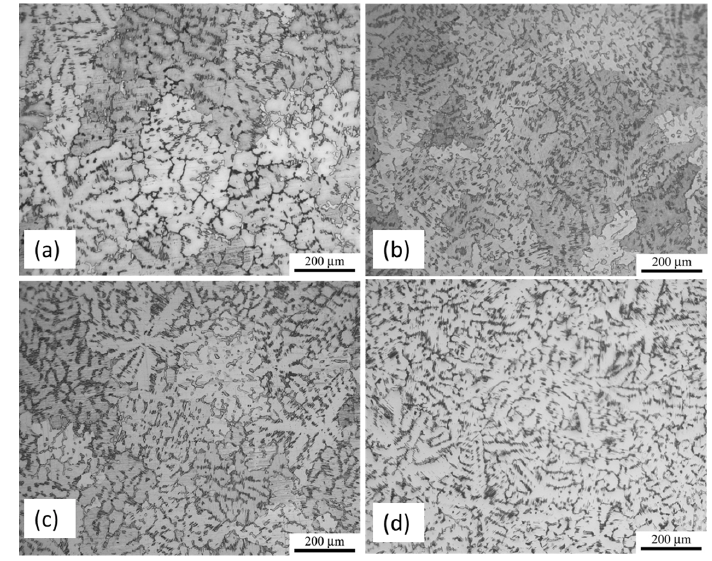
Figure 1. Optical micrographs of ( a ) MgZnY-C; ( b ) HA-C; ( c ) MgZnY-H; and ( d ) HA-T alloy.